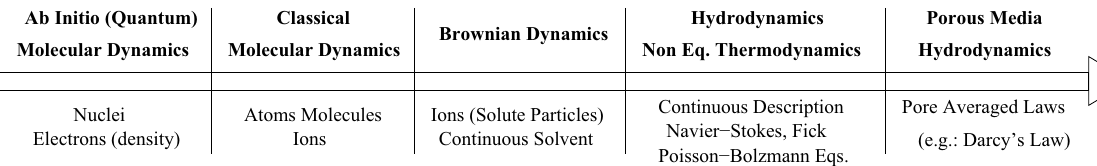
Fig. 1 – Various levels of description for the dynamics in charged porous systems. Upper part: simulation and theoretical techniques. Lower part: ingredients of the